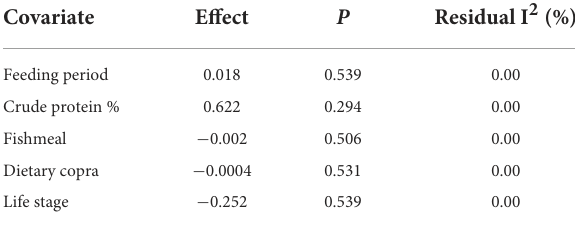
TABLE 7 Meta-regression for ash.